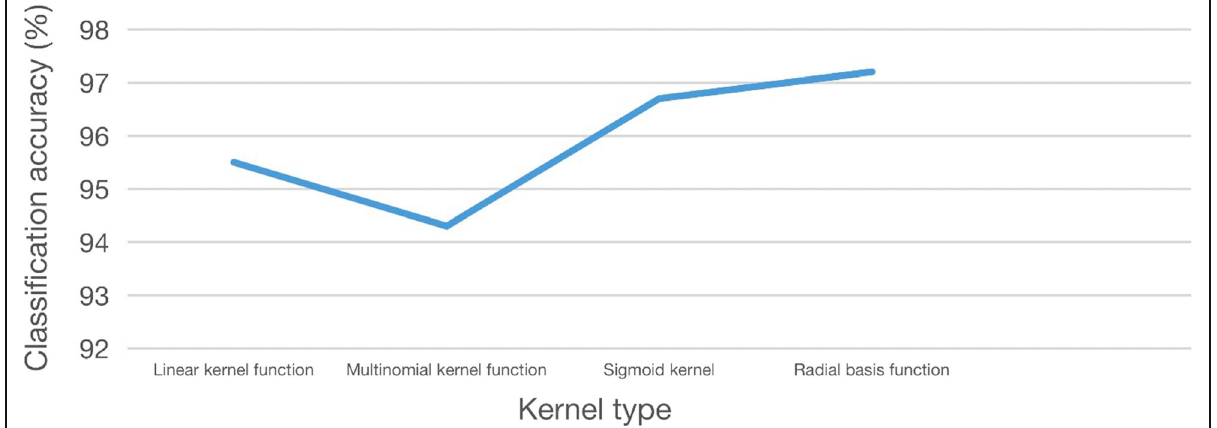
Fig. 4 SVM performance comparison diagram using different Kernel functions